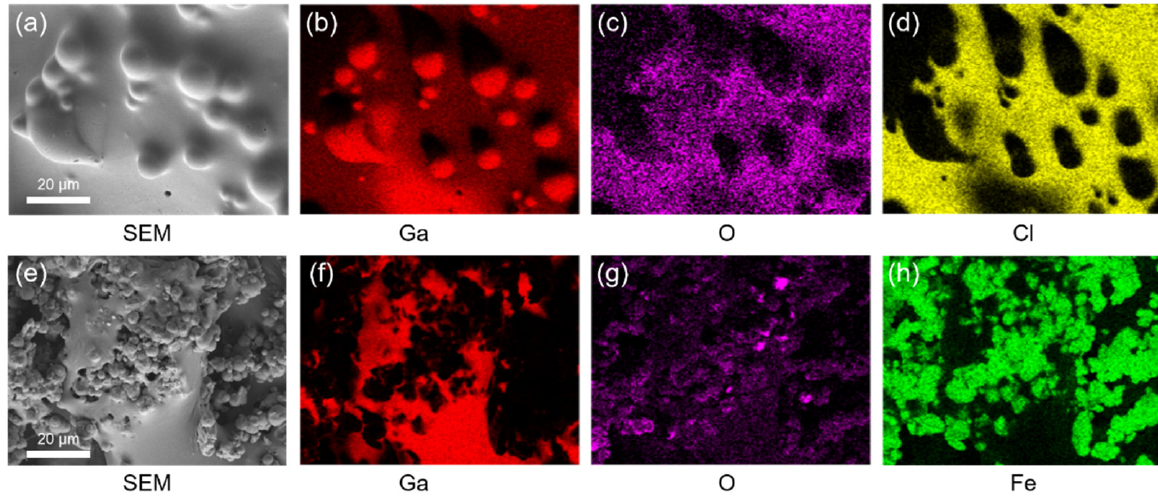
Figure 2. ( a ) SEM image and ( b – d ) Energy dispersive spectroscopy (EDS) element mapping images for ( b ) Ga, ( c ) O, ( d ) Cl on the surface of magnetic liquid metal prepared in the absence of oxide layer on gallium. ( e ) SEM image and ( f – h ) EDS element mapping images for ( f ) Ga, ( g ) O, ( h ) Fe on the surface of magnetic liquid metal prepared in the presence of oxide layer on gallium.